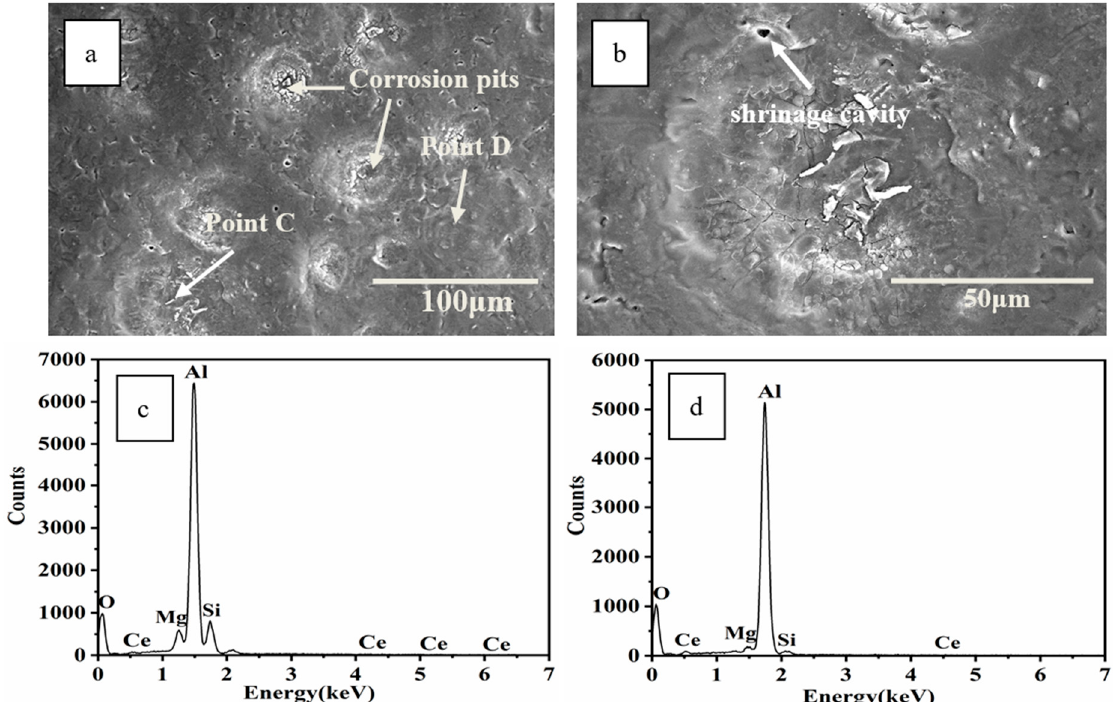
Figure 11. Surface morphology of 25-pulse-treated Al–20Si–5Mg–0.7Ce alloy surfaces after electrochemical corrosion testing. ( a ) Low magnification micrograph; ( b ) high magnification micrograph, enlarged micrograph of Figure 11a; ( c ) EDS profile of point C in Figure 11a; ( d ) EDS profile of point D in Figure 11a.